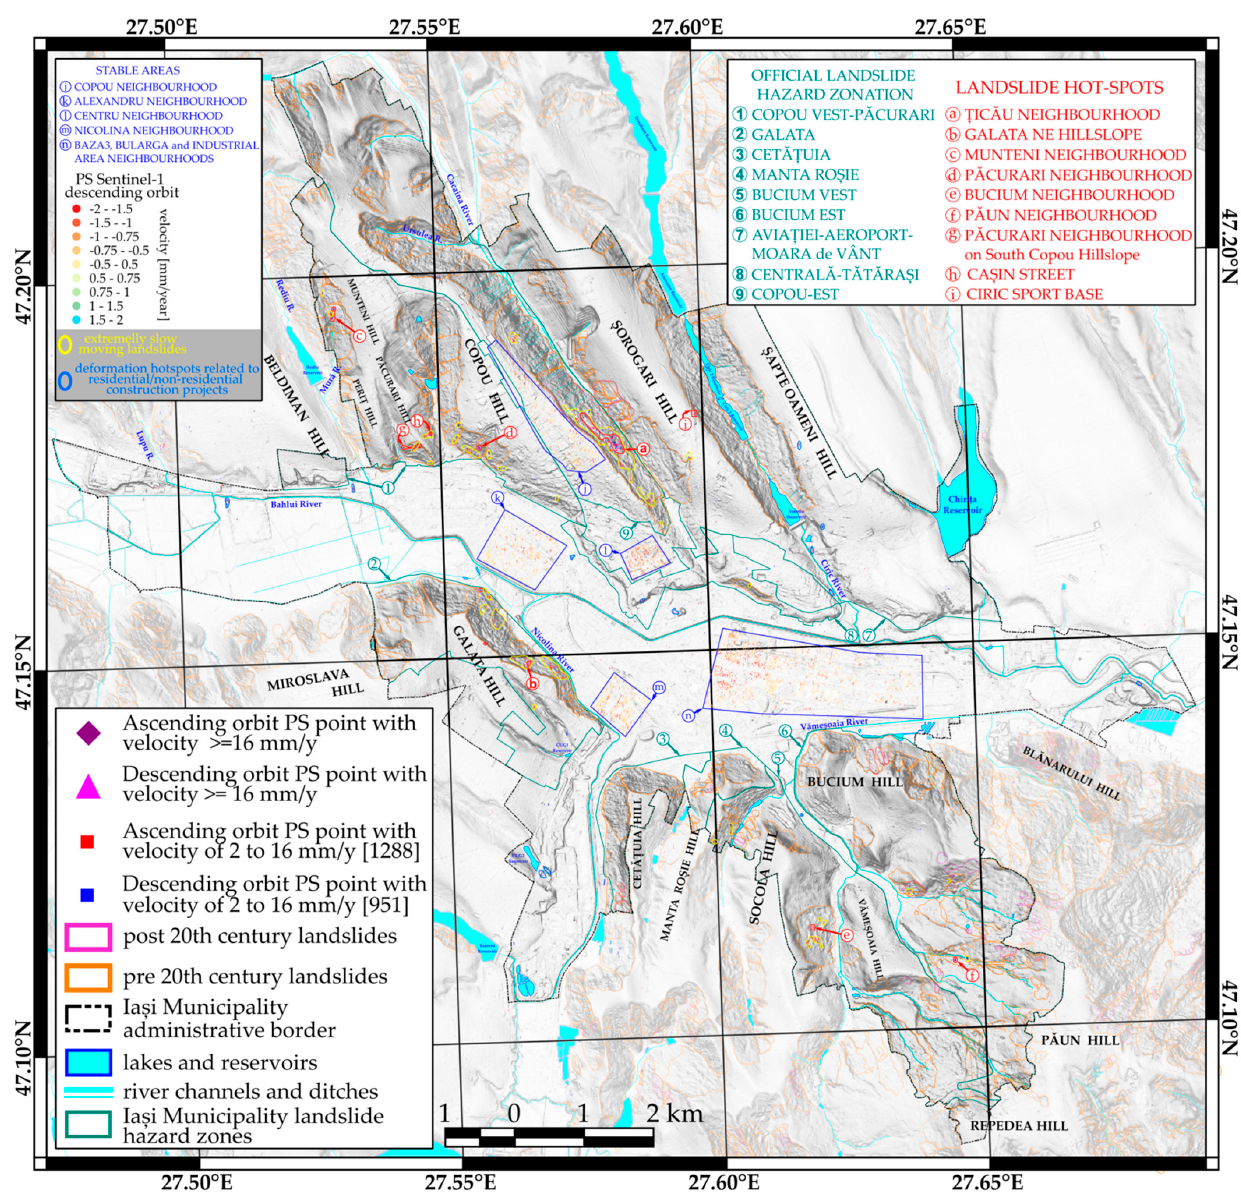
Figure 8. The official landslide hazard zonation, the landslide velocity hot-spots identified in the present study, and the mapped landslides by [62,79] in Iasi Municipality. (high-resolution image available at https://doi.org/10.6084/m9.figshare.14916003.v2).